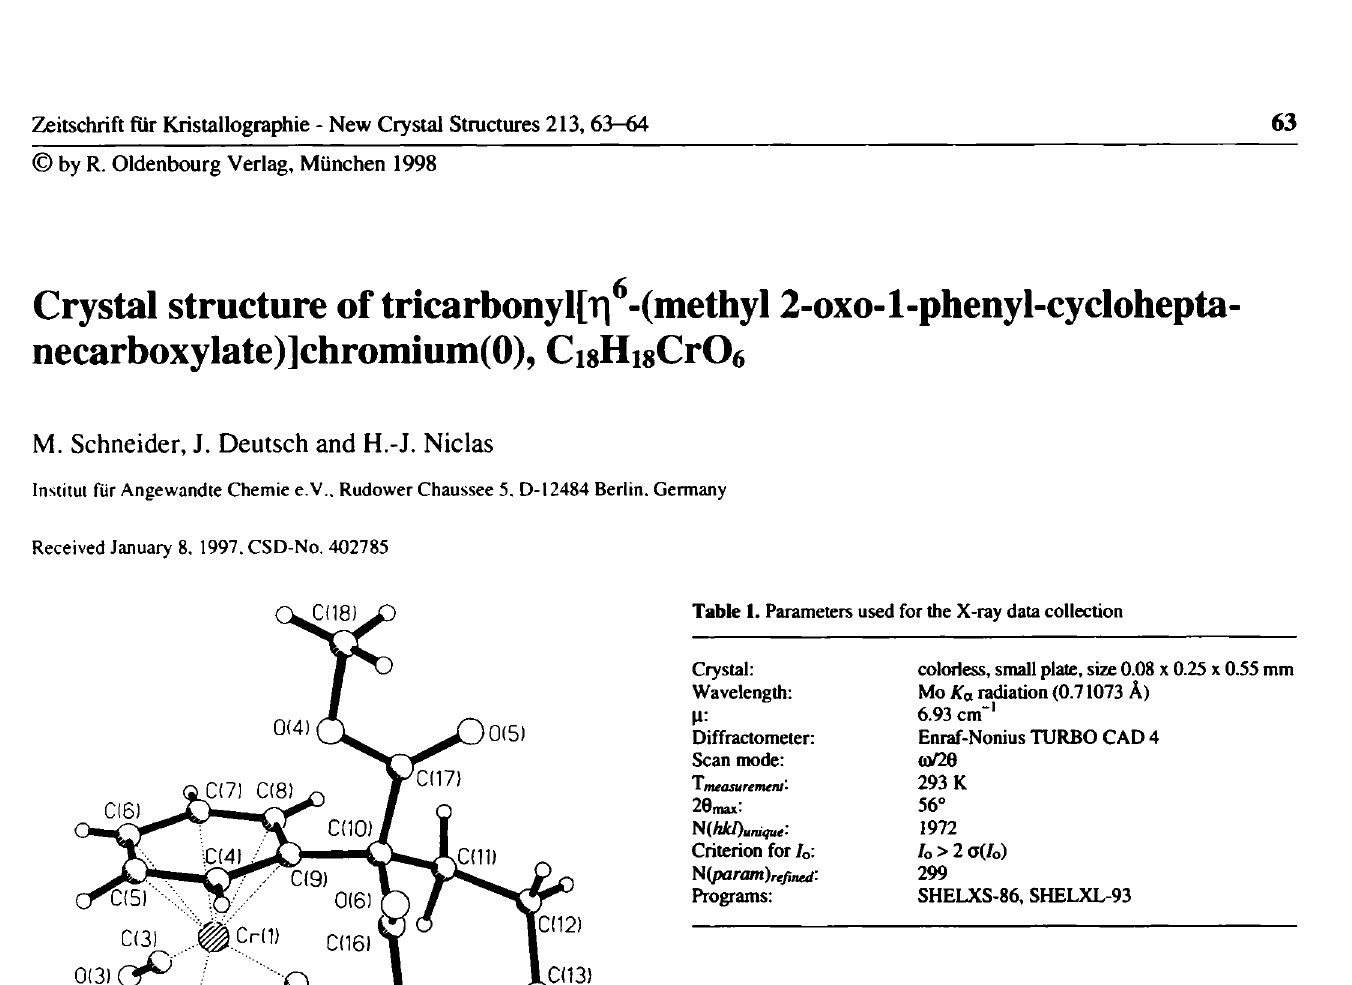
Table 2. Rnal atomic coordinates and displacement parameters (in